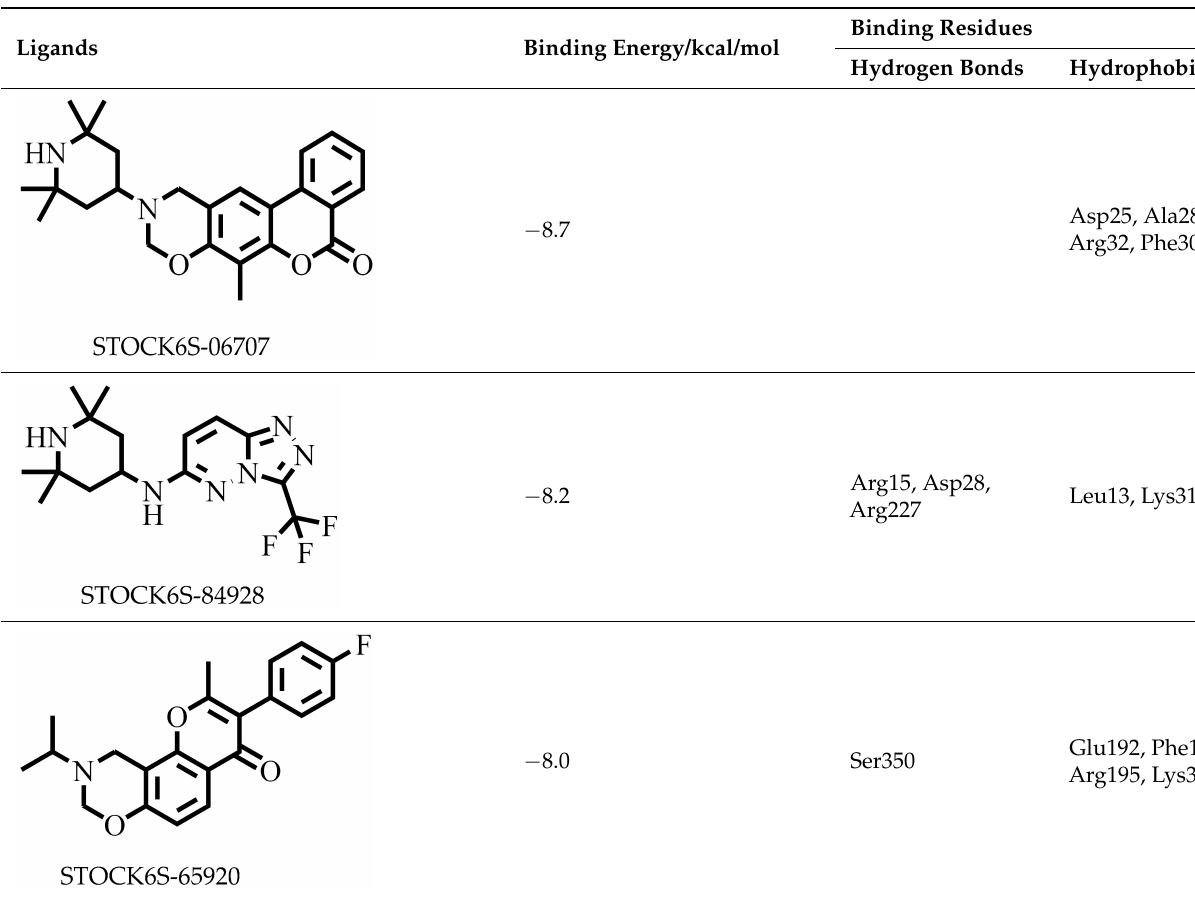
Table 2. Binding energies of the selected compounds after molecular docking with generated inter- molecular